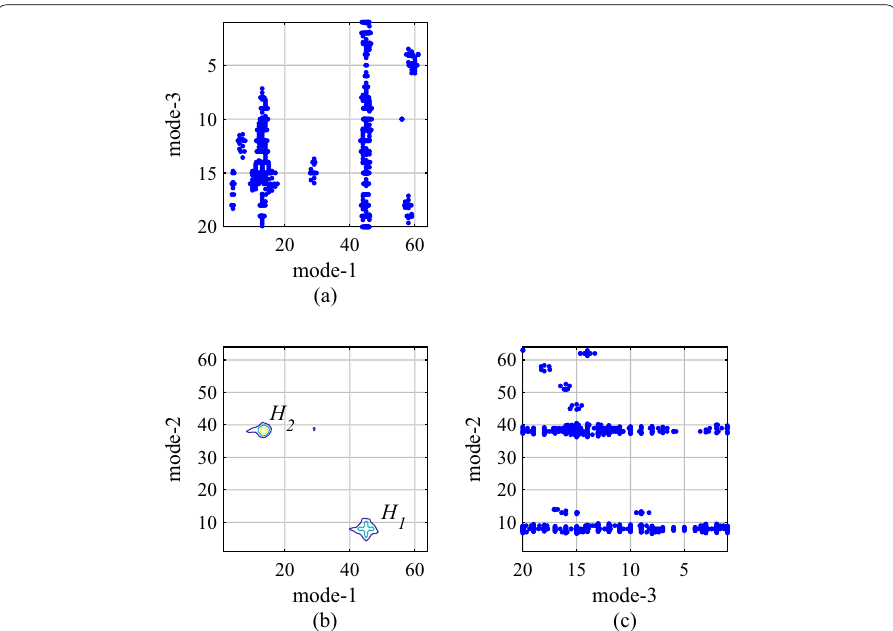
Fig. 4 Phase congruency in computed tensor M in Fig. 1. a , c Scatter plots for the 20 frames along mode-3. b 3-level contour